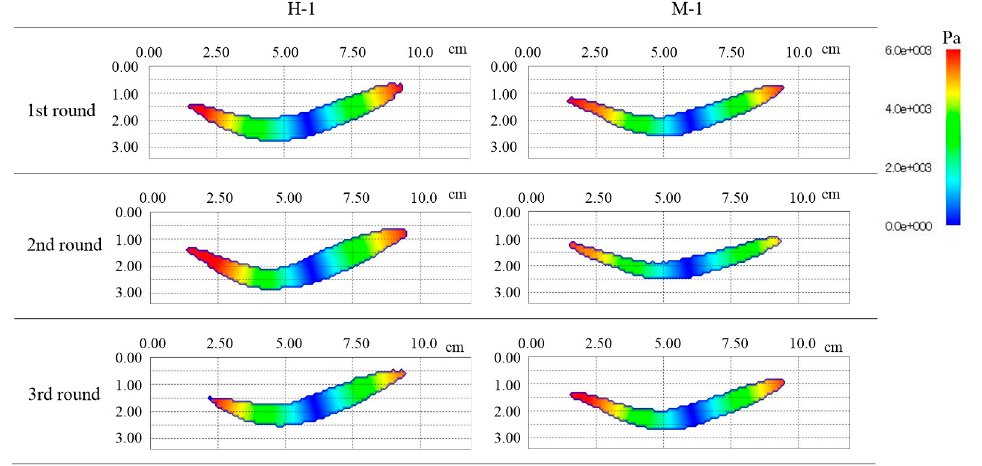
Figure 17. Pressure distribution from the simulation results.